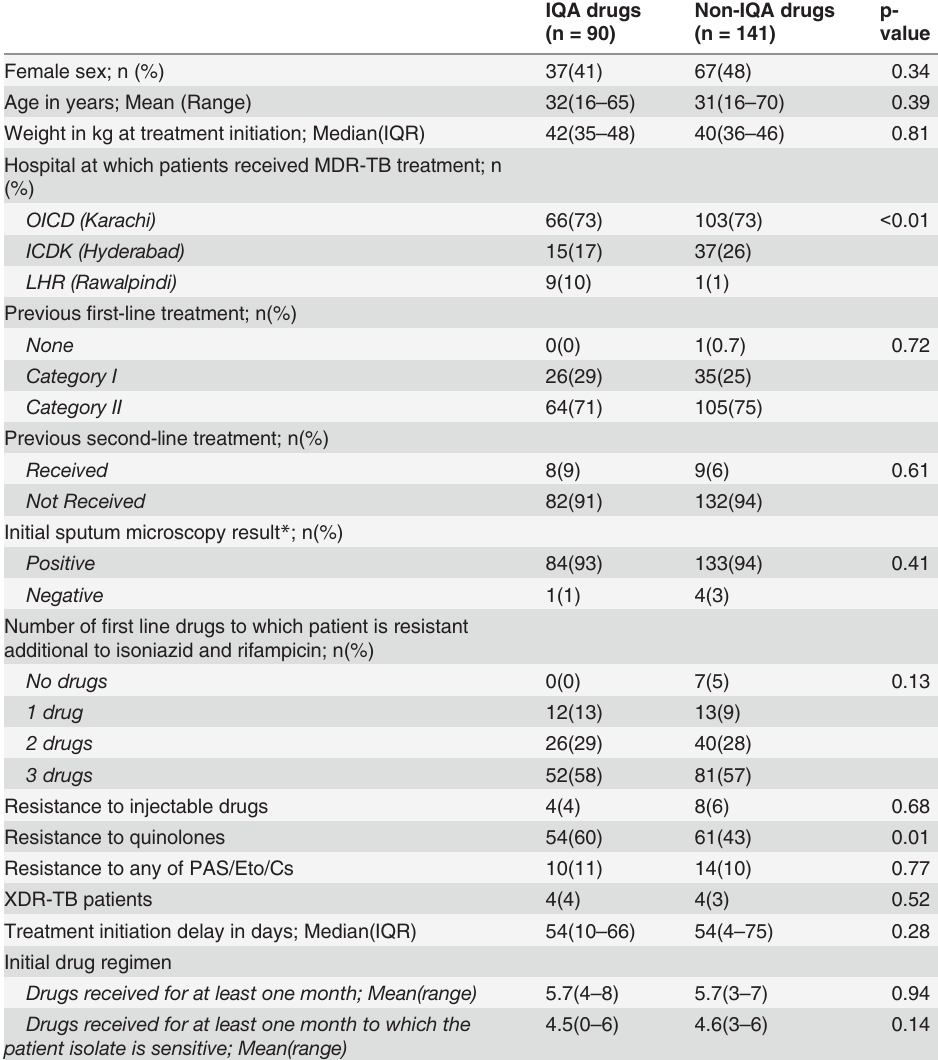
Table 1. Patient characteristics at baseline by cohort (n =